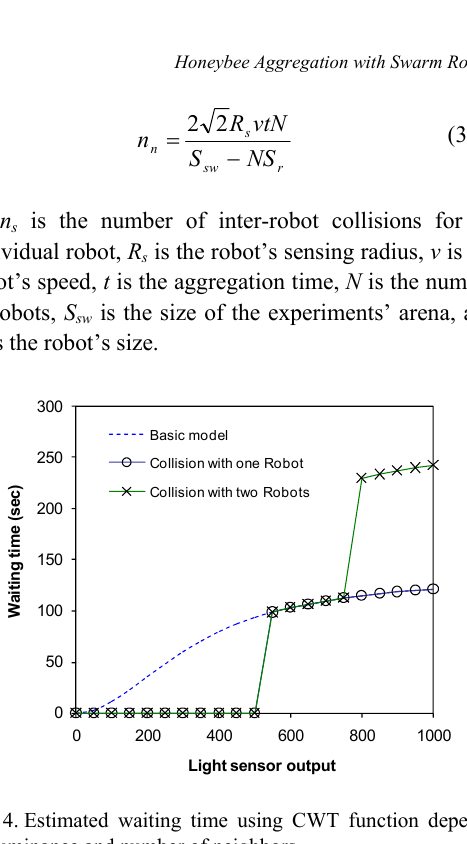
Fig. 4. Estimated waiting time using CWT function depends on luminance and number of